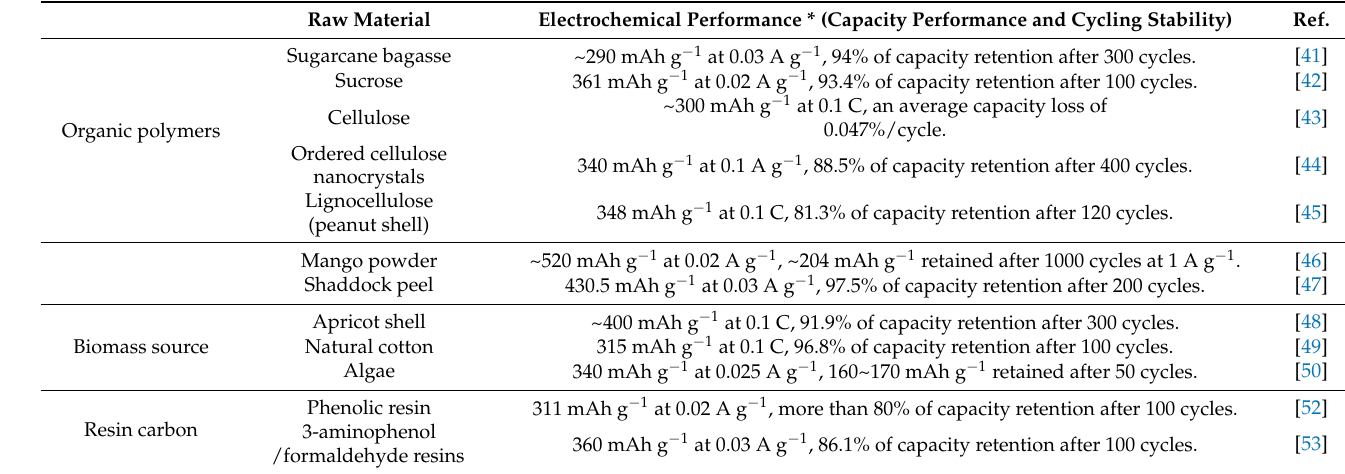
Table 2. Electrochemical performance of anodes synthesized from different raw materials. Raw Material Electrochemical Performance * (Capacity Performance and Cycling Stability) Ref.